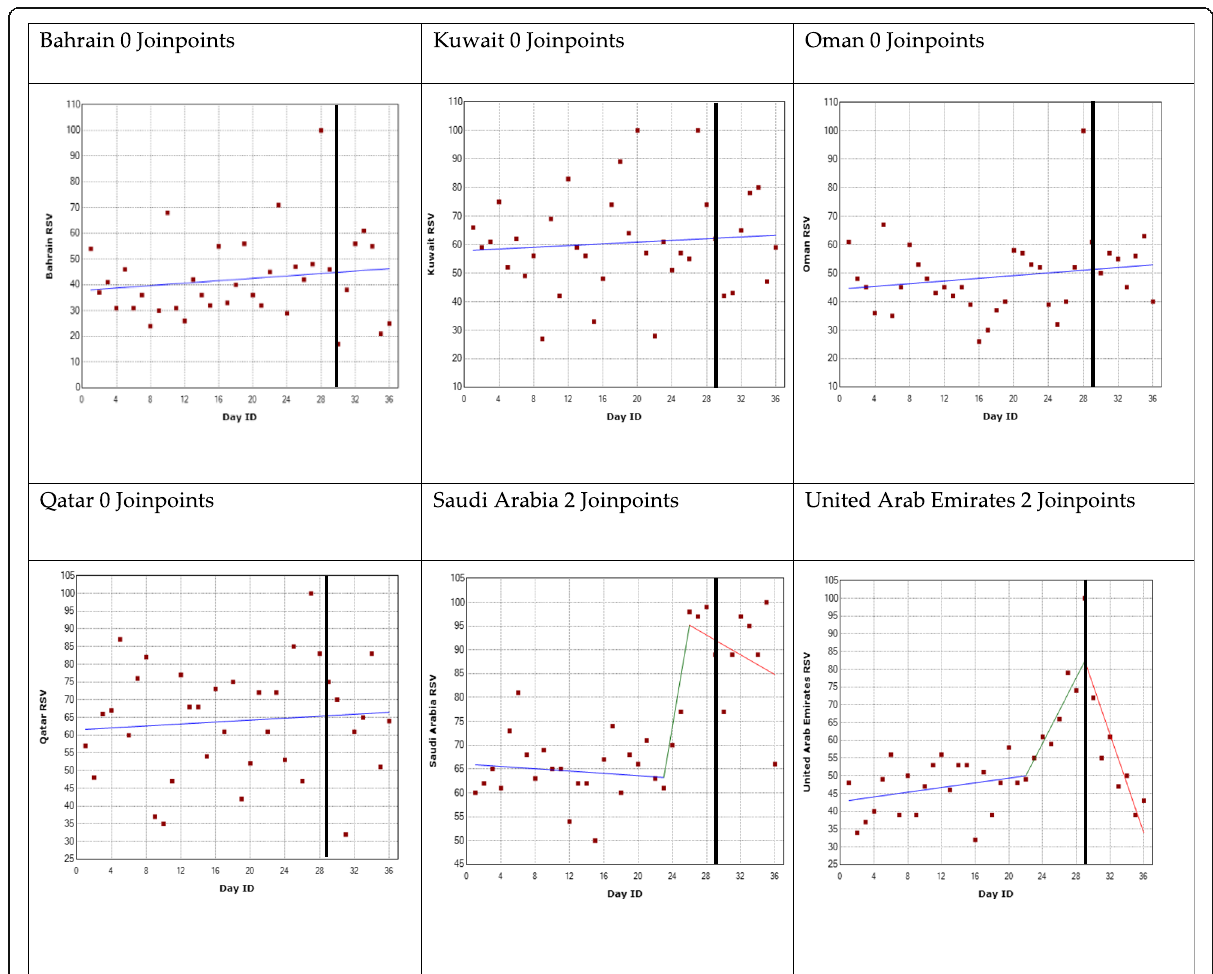
Fig. 2 World Diabetes Day joinpoint regression analysis. *The black vertical line represents the global public health